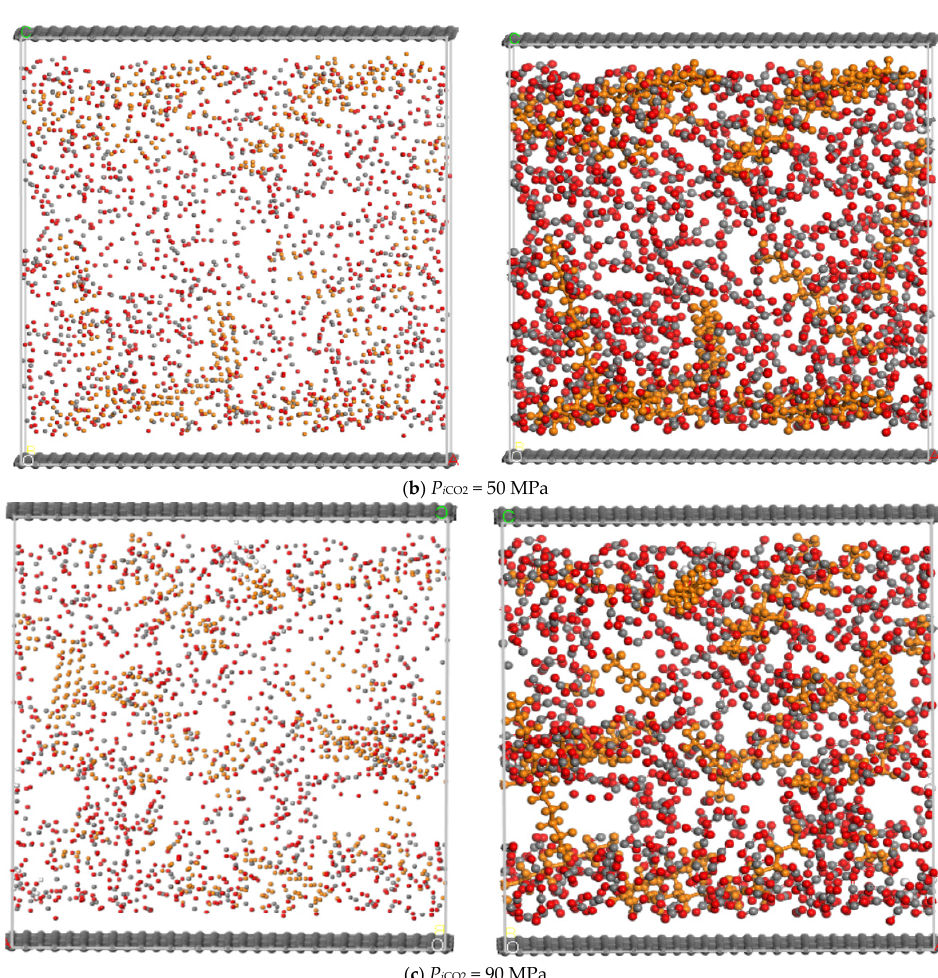
Figure 2. The schematic of instantaneous adsorption of molecules with CO 2 injection under different injection pressure. (A, B and C respectively represent different coordinate directions).